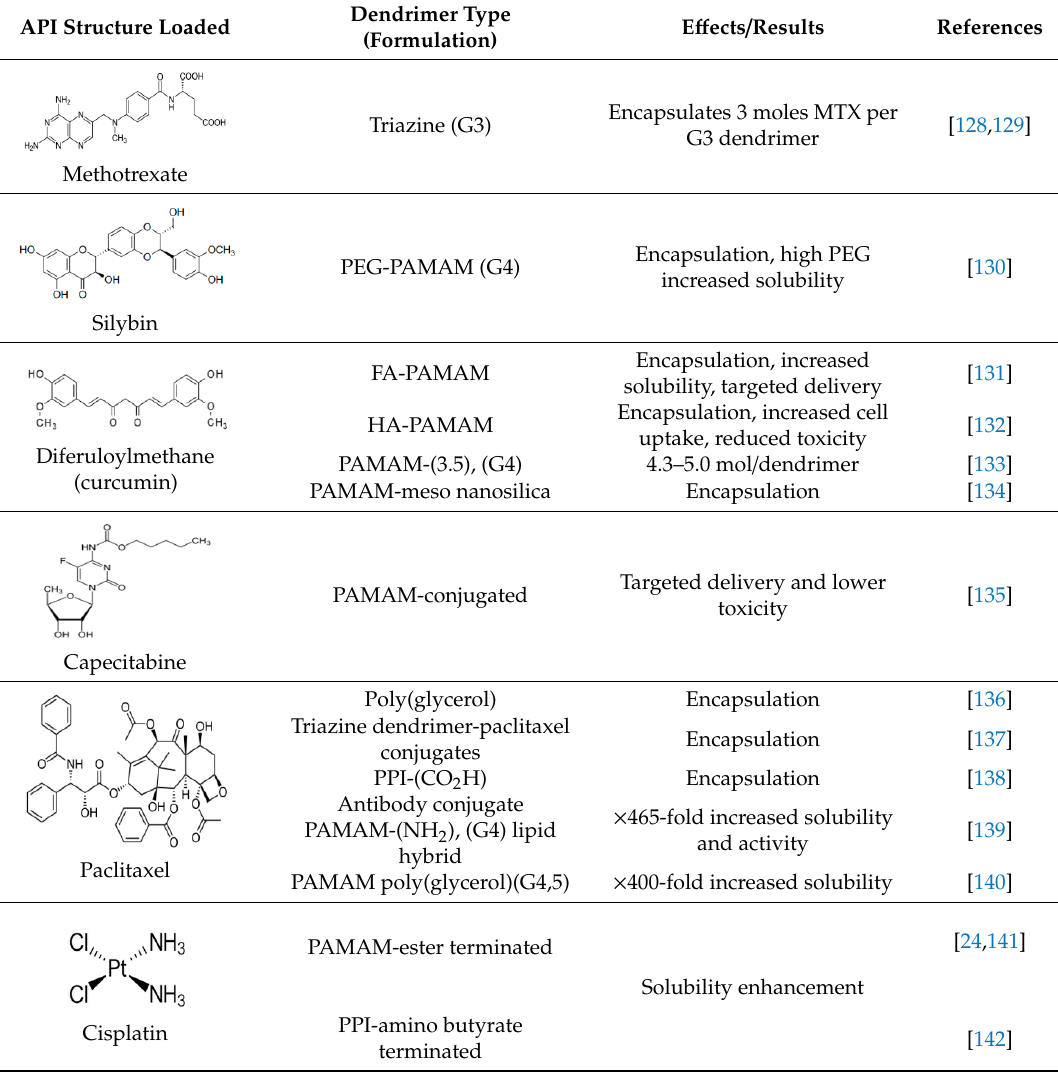
Table 2. Anti-cancer Table 2. Anti-cancer Drugs. Table 2. Anti-cancer Drugs. Table 2. Anti-cancer Drugs. Table 2. Anti-cancer Drugs. Table 2. Anti-cancer Drugs. Table 2. Anti-cancer Drugs.